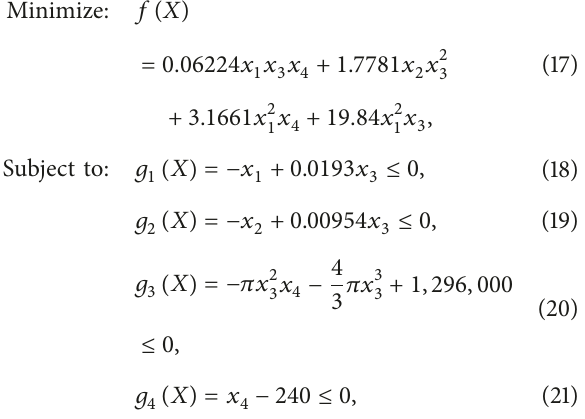
Figure 23: 𝐷 = 30 , ANOVA test of global minimum for 𝑓 01 .